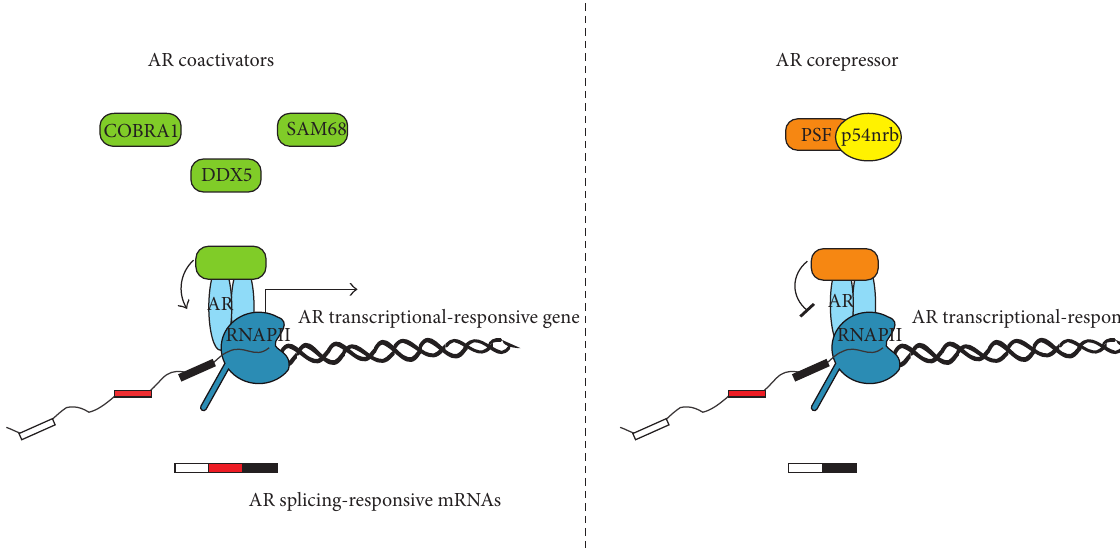
Figure 2: Regulation of cotranscriptional splicing by proteins interacting with the androgen receptor. Coregulators of the androgen receptor (AR) can affect splicing of target genes by direct interaction with AR and modulation of its activity. COBRA1, SAM68, and DDX5 appear to promote the transcriptional activity of AR but differentially act on splicing of variable exons (red box in the left side of the figure); PSF and its interacting protein p54 (right side of the figure) repress the transcriptional activity of AR, but their effect on splicing is currently unknown (see text for more